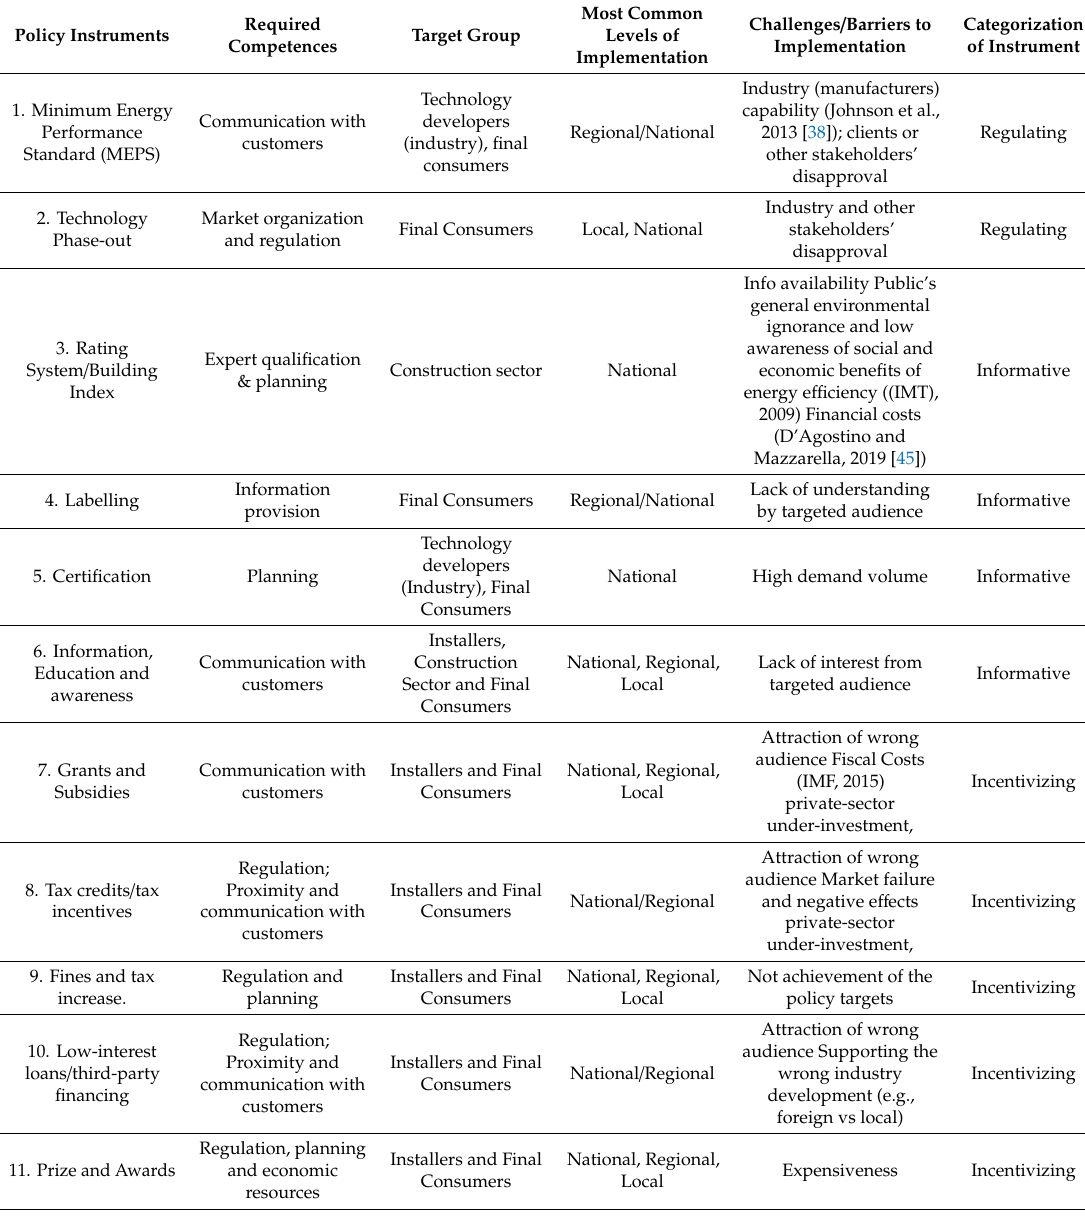
Table 5. Policy instruments characterization / relation between technical measures and policy